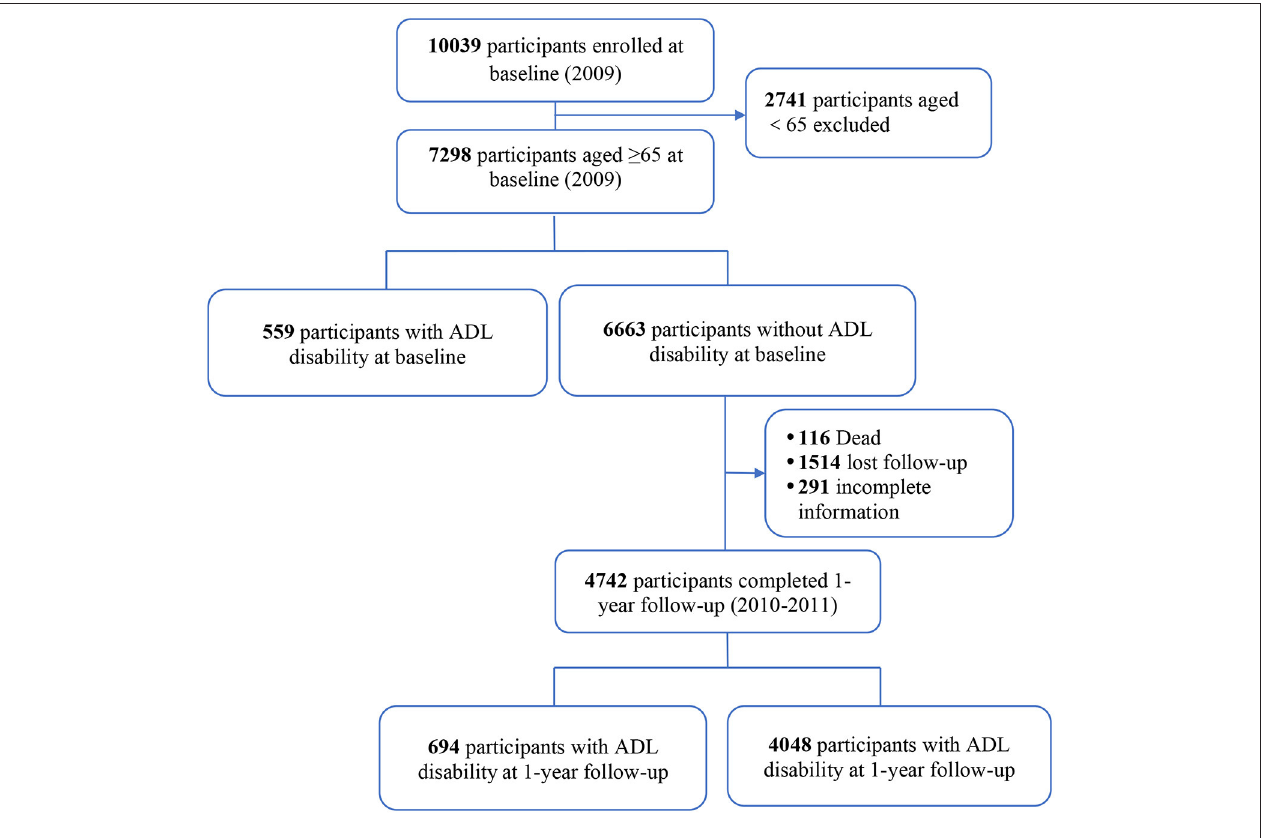
FIGURE 1 | Flowchart of the study